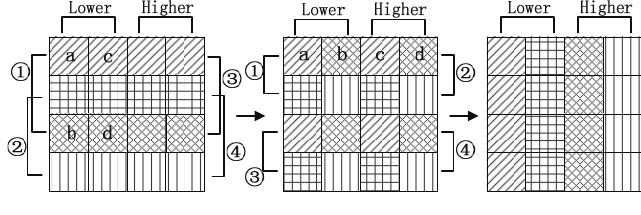
Figure 8. Transpose SAR data by interleaving